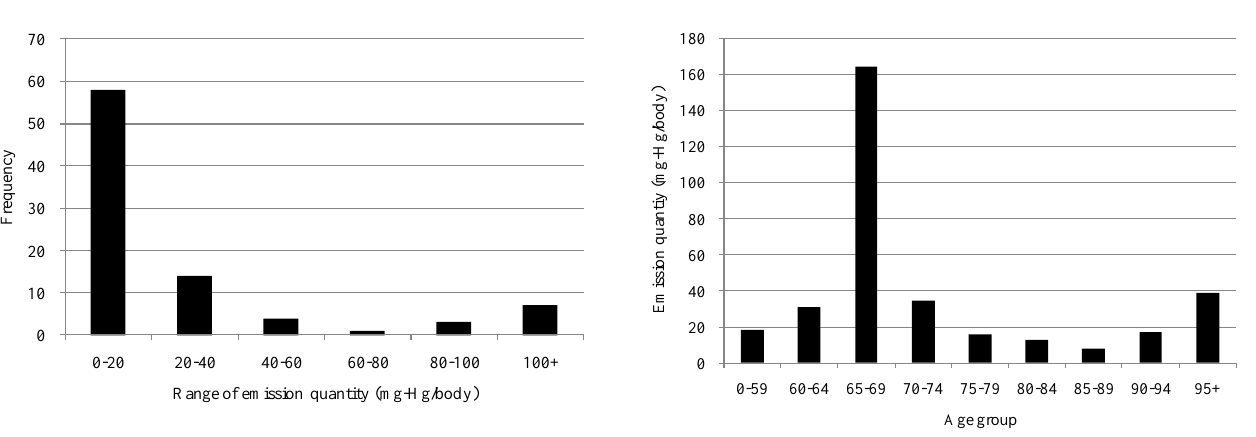
Fig. 5. The amount of mercury emission per cremation calcu- lated using measured data by age group (number of samples by age Figure 5. The amount of mercury emission per cremation calculated using measured group: 0–59:4, 60–64:6, 65–69:7, 70–74:9, 75–79:15, 80–84:17, data by age group (number of samples by age group: 0–59:4, 60–64:6, 65–69:7, 85–89:9, 90–94:12, 70–74:9, 75–79:15, 80–84:17, 85–89:9, 90–94:12, 95+:8)